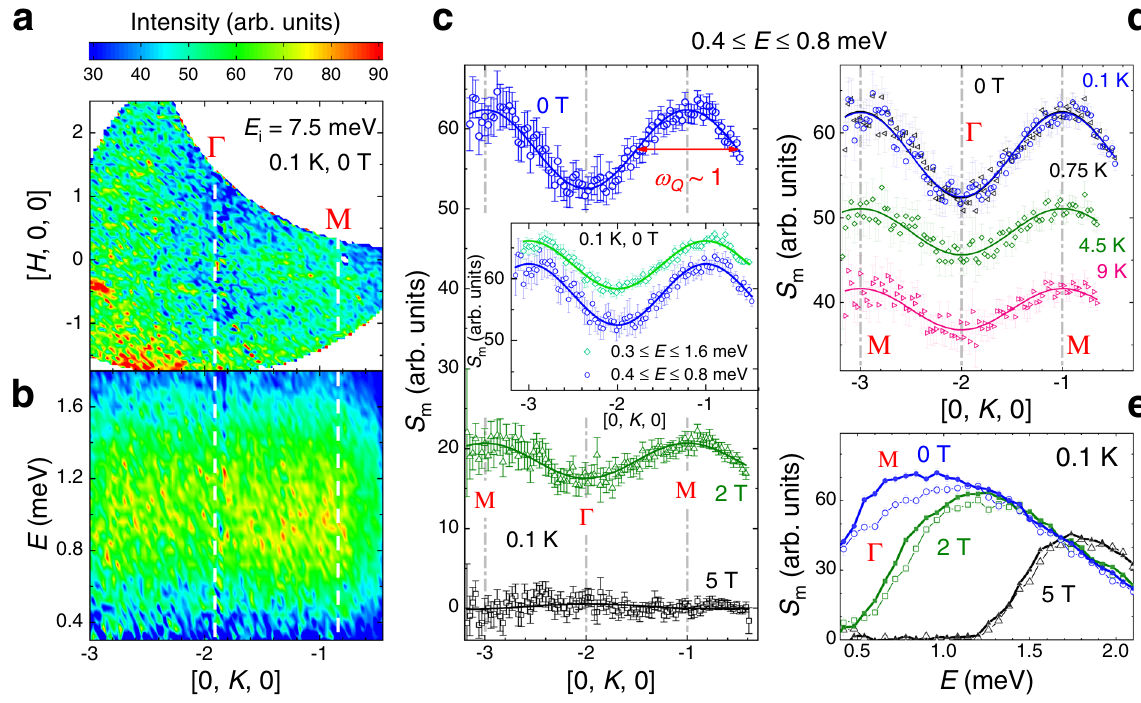
Fig. 3 INS spectra of the PrTiNbO 6 single crystal measured with E i = 7.5 meV. a Wave-vector dependence of the spin excitation continuum measured at 0.4 ≤ E ≤ 0.8 meV at 0.1 K. b Energy dependence of the continuum along the b axis. c , d Wave-vector dependence of the dynamic spin-correlation function measured at selected longitudinal fi elds at 0.1 K and measured at various selected temperatures under zero fi eld, respectively. The colored lines are guide for the eye and the dashed gray lines mark the high-symmetry reciprocal-space points ( Γ and M points). In c the FWHM of the hump ( ω Q ) is marked, and the inset shows the data integrated over different energy ranges. e Energy dependence of the measured intensities at the M (solid scatters) and Γ (open scatters) points, respectively. The 8.8 T data provides the elastic background below 2 meV, which has been subtracted in the INS data shown in ( a − e ). Error bars on INS data indicate one standard error propagated from neutron